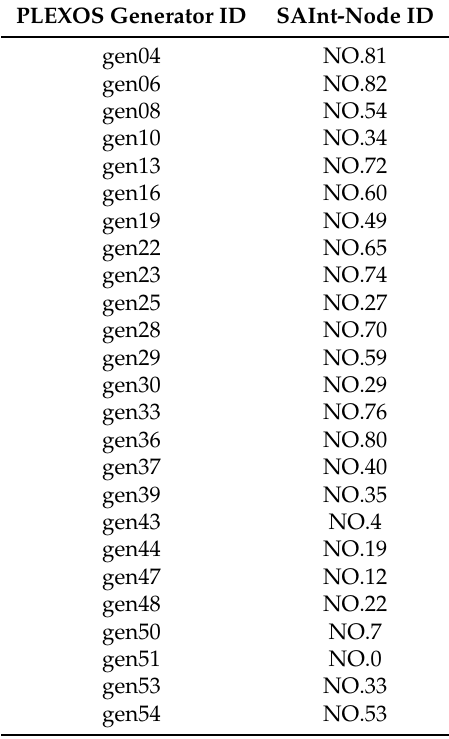
Table 3. Mapping between power system nodes in PLEXOS and gas system nodes in SAInt for the 25 gas fired